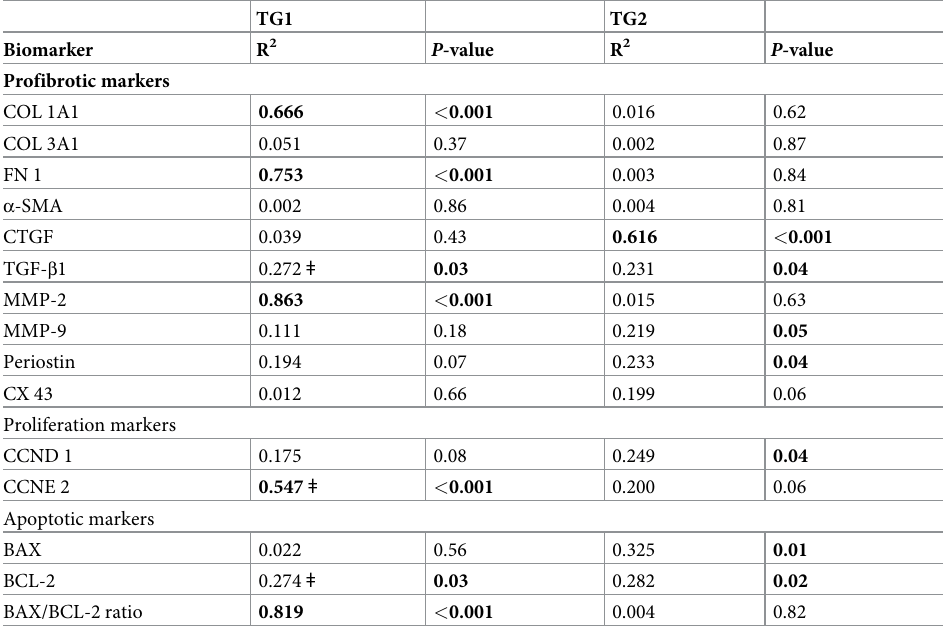
P -values in bold indicate a statistically significant correlation. ǂ denotes negative correlations. Collagen 1A1: COL 1A1; Collagen 3A1: COL 3A1; Fibronectin 1: FN 1; α -smooth muscle actin: α -SMA; Connective tissue growth factor: CTGF; Transforming growth factor β 1: TGF- β 1; Matrix metalloproteinase-2: MMP-2; Matrix metalloproteinase-9: MMP-9; Connexin 43: CX43, Cyclin D1: CCND 1; Cyclin E2: CCNE 2; BCL-2-associated X protein: BAX; B-cell lymphoma 2: